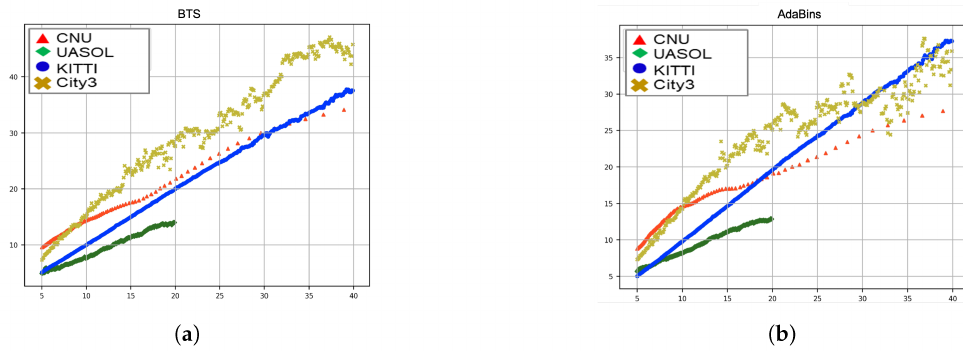
Figure 3. Mono depth estimation results for KITTI, CNU, RADIATE, and UASOL datasets using three models. Each model trained using KITTI datasets. ( a ) BTS, and ( b ) AdaBins.